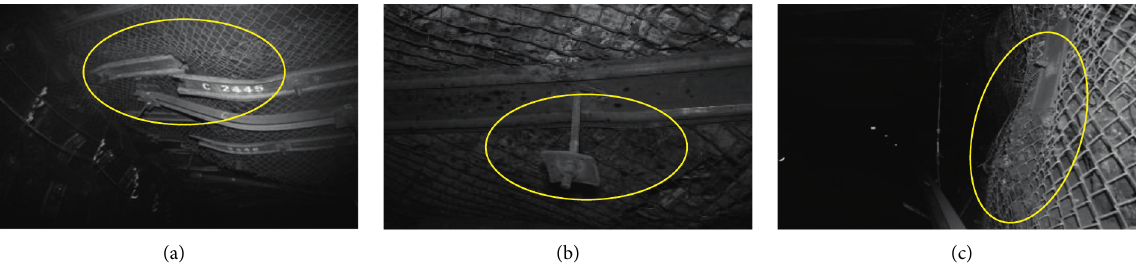
Figure 3: Actual picture of support failure of air return roadway of 2203. (a) Failure of W-shaped steel. (b) Roof bolt cutting. (c) Coal pillar bulge.